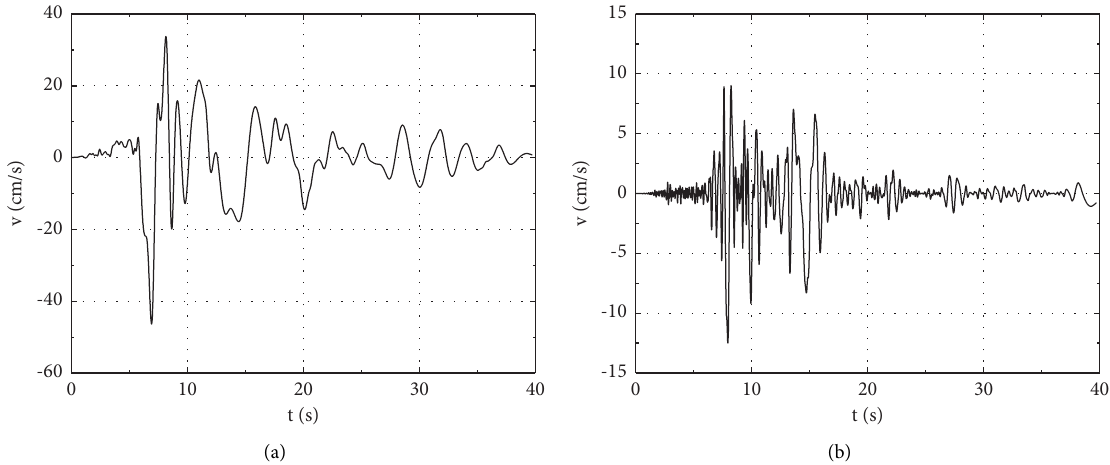
Figure 7: The ground motion signal. (a) The low-frequency signal. (b) The high-frequency signal.